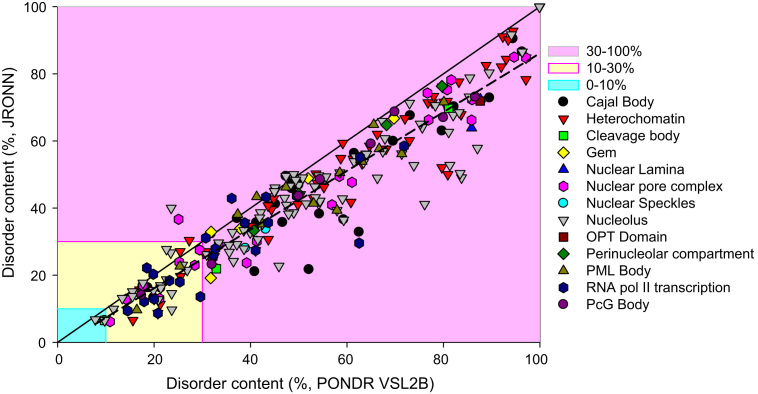
Abundance of intrinsic disorder in human nuclear proteins. JRONN vs. PONDR® VSL2B plot representing the correlation between the disorder content evaluated by PONDR® VSL2B (x-axis) [40], [41] and by JRONN (y-axis) [42]. Solid black line corresponds to the diagonal. Dashed line shows linear fit of all the data point to the equation (R2=0.90):.DSJRONN=–1.4±1+0.85±0.02×DSPONDR.Following the accepted practice, two arbitrary cutoffs for the levels of intrinsic disorder are used to classify proteins as highly ordered (IDP score<10% light blue field), moderately disordered (10%≤IDP score<30%, light yellow field) and highly disordered (IDP score≥30%, light pink field) [48].